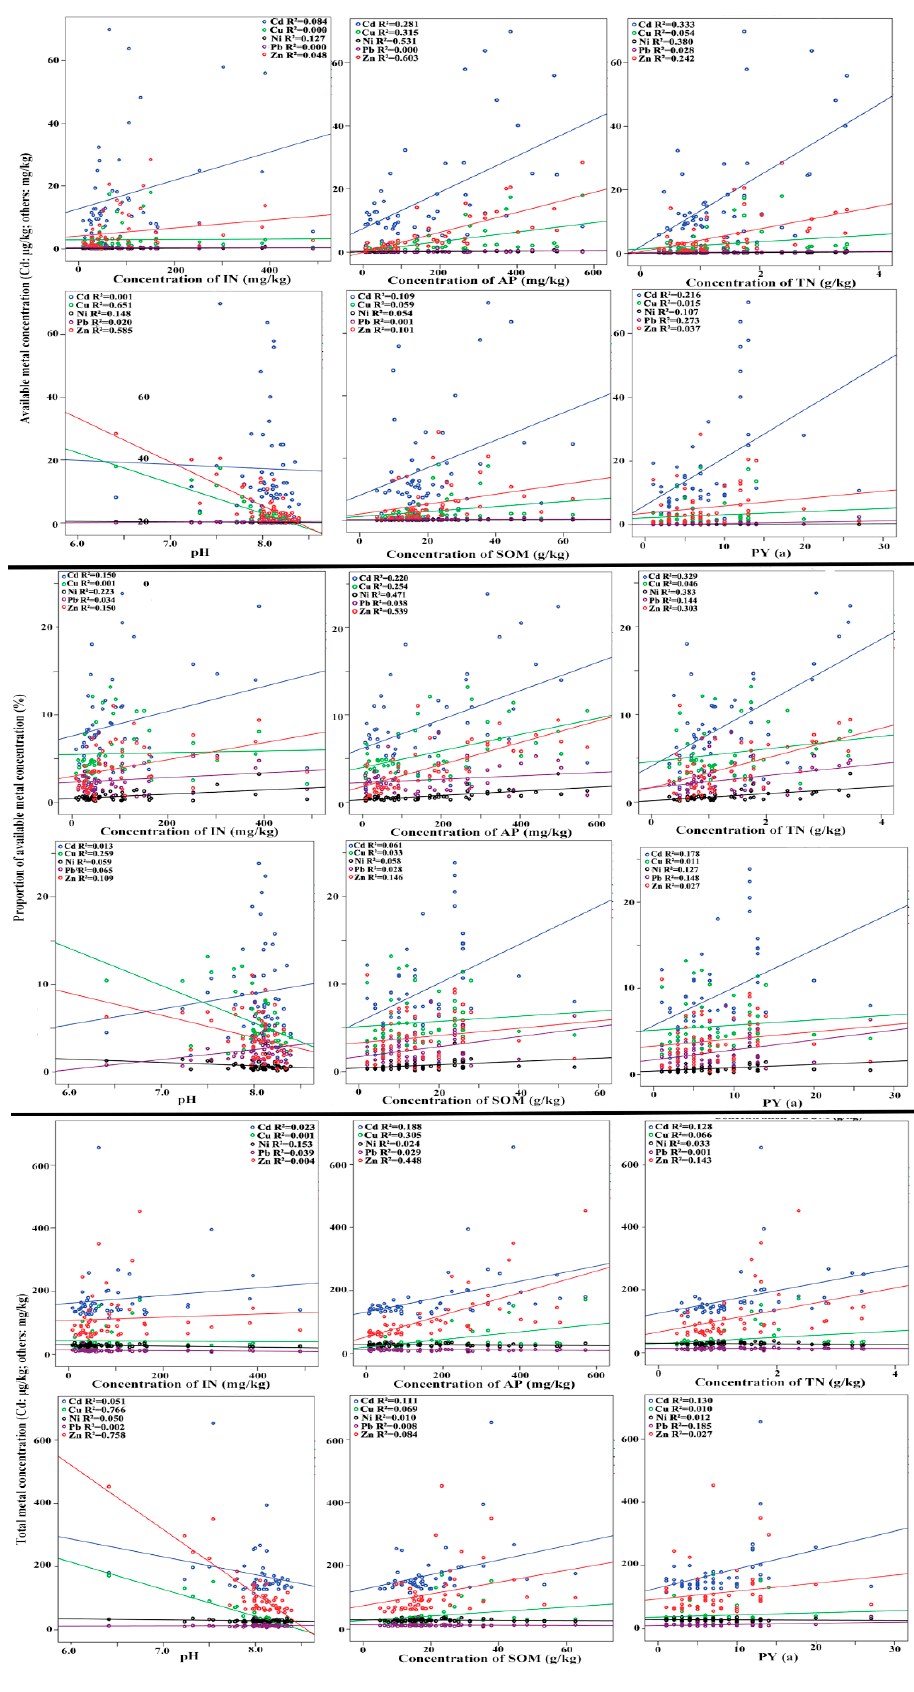
Figure 3. Correlations between metals and soil factors.